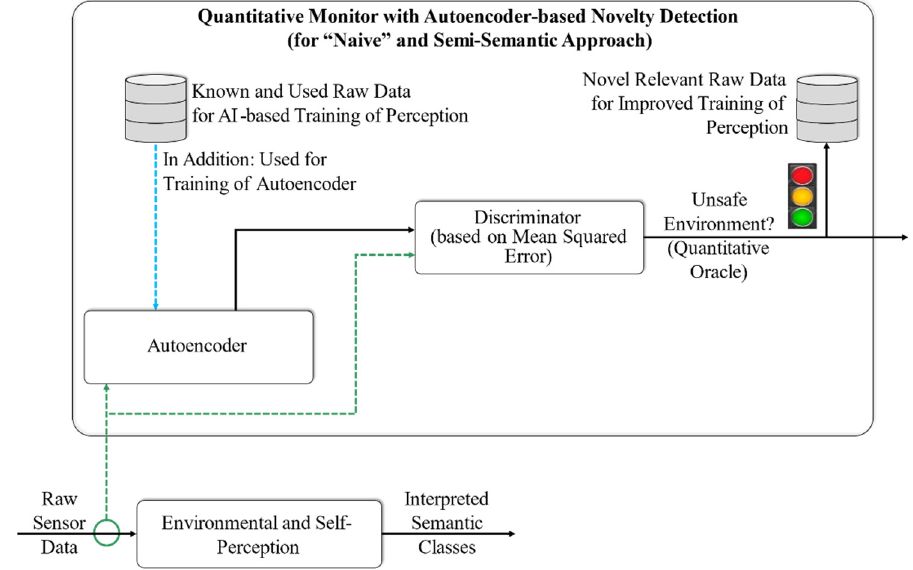
Figure 6. Quantitative monitor with autoencoder-based novelty detection.